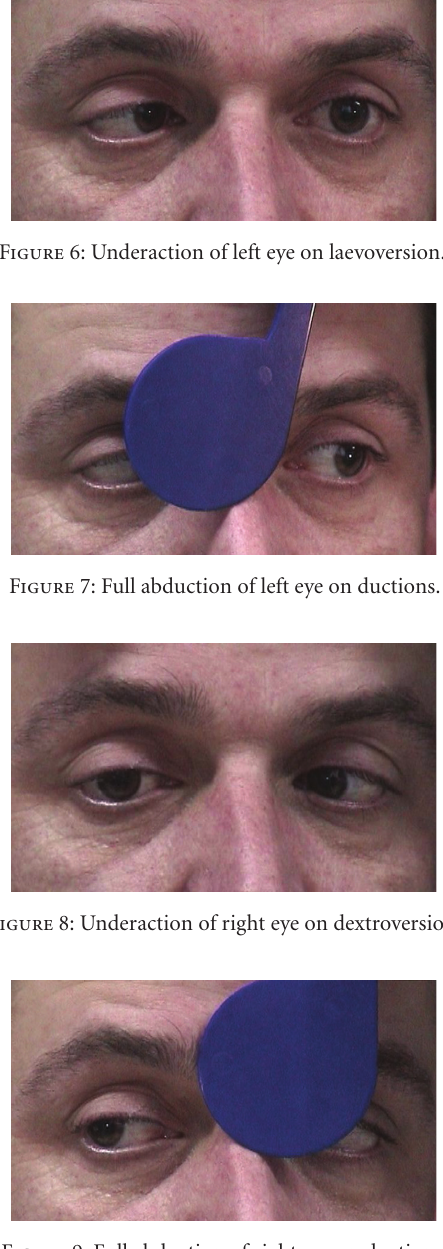
Figure 4: Right esotropia.